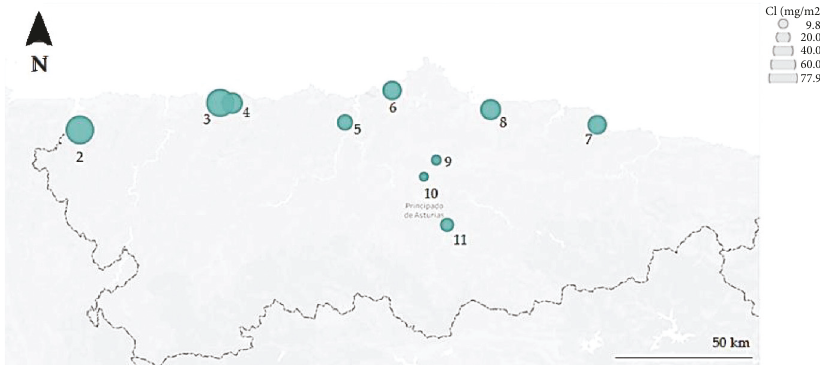
Figure 8: Results of test II, representation of deposition at each study